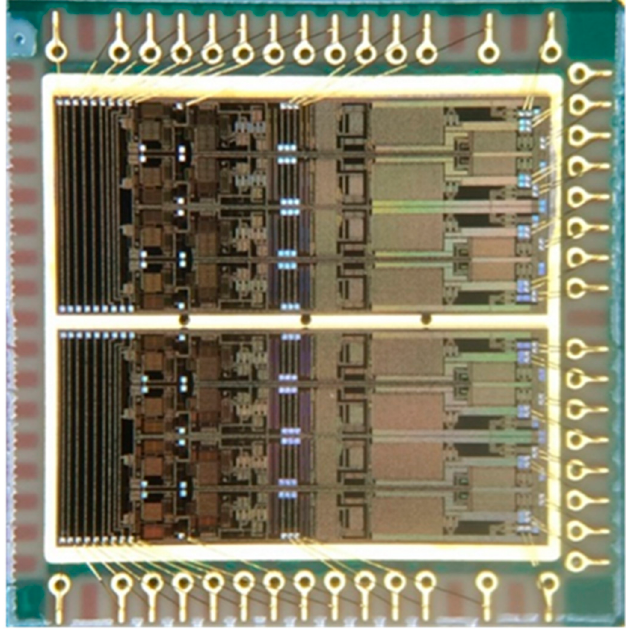
Figure 18. The photo of the integrated eight-channel high-voltage pulse driver.